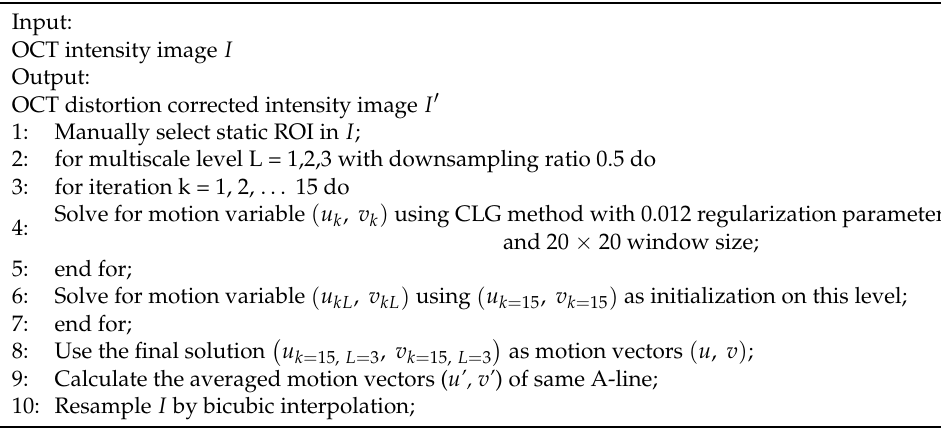
Table 1. Framework of the CLG distortion